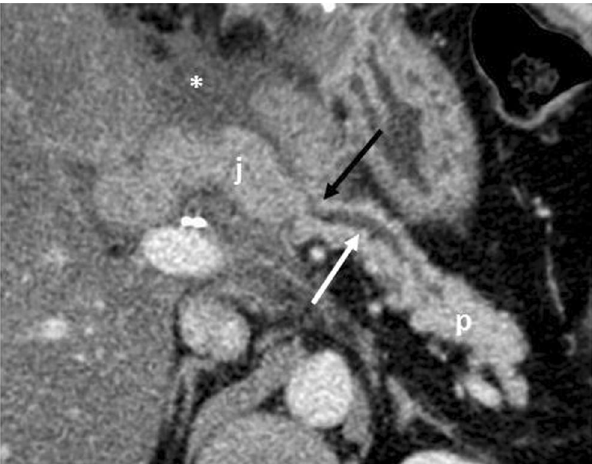
Fig. 12 Oedema of the pancreaticojejunostomy. Axial CT image in the immediate postoperative period shows a mild thickening of the jejunum (j) at the pancreatic anastomosis (black arrow) due to acute oedema. This condition leads to a dilation of the main pancreatic duct (white arrow). A fluid collection is visible surrounding the anastomotic jejunal loop (*)